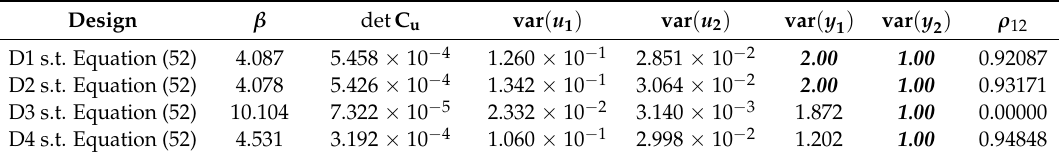
Table 5. Wood and Berry column, G 2 ( s ) . Results for different experiment designs. GBN signals in D3 and D4 are based on switching probability, p sw = 0.05, and mean switching time, E [ T sw ] = 20 min. Active constraints are shown in bold